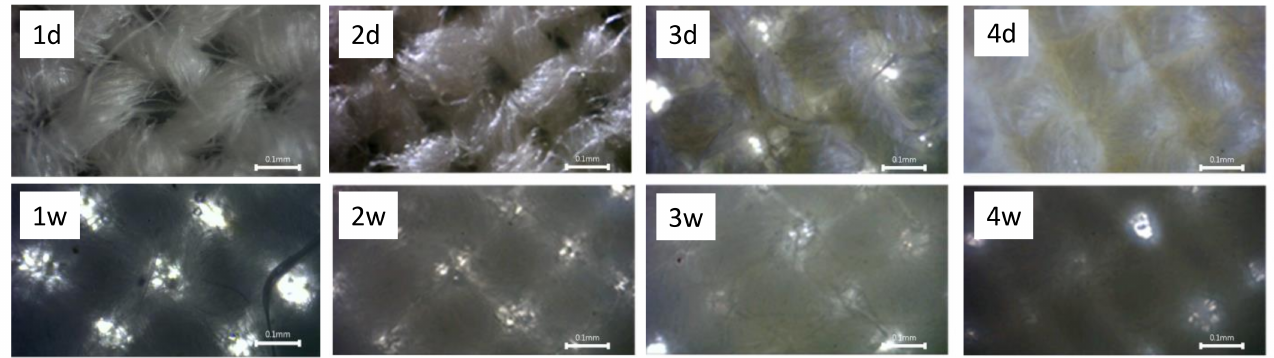
Figure 2. Optical microscope photographs of cotton fabric ( 1d , 1w ) and composite materials Ch ( 2d , 2w ); ChZn ( 3d , 3w ); and ZnChZn ( 4d , 4w ). In the top row, the samples are in a dry state, and, in bottom row, are after wetting with water (magnification of the pictures is ×